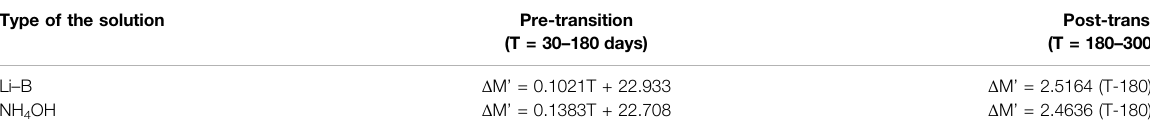
TABLE 3 | Fitted weight gain – corrosion time relationships of the Zr – Sn – Nb alloys.